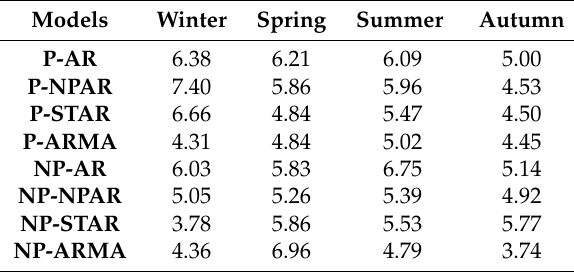
Figure 4. MAPE values of one month ahead post-sample forecasts for all models. Table 3. One month ahead post-sample forecasts MAPEs with respect to seasons of the